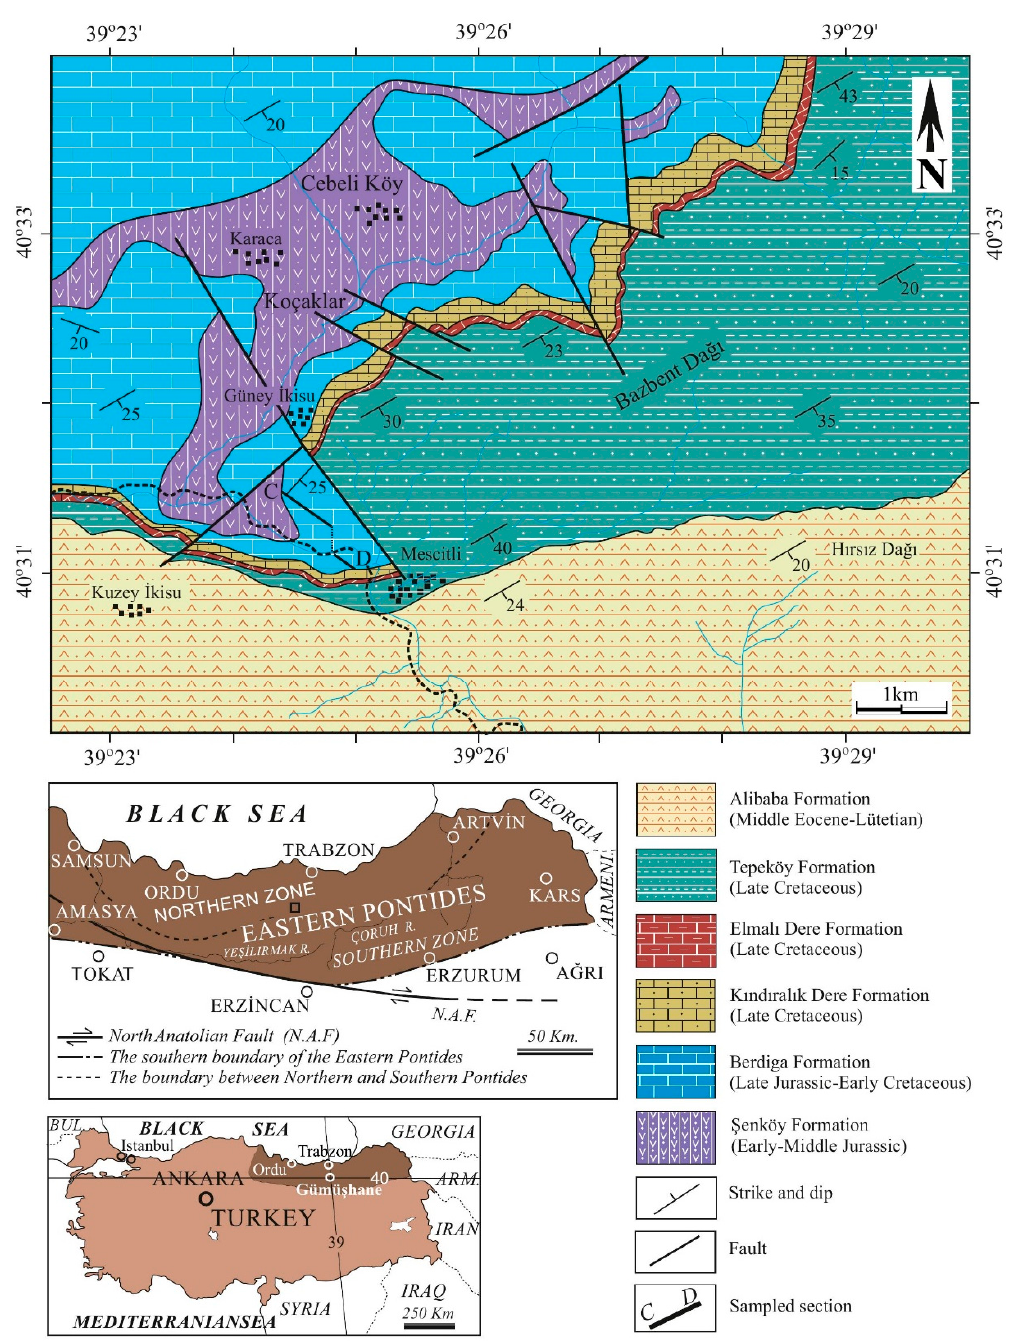
Figure 1. Location and simplified geological map of the Mescitli area [54].